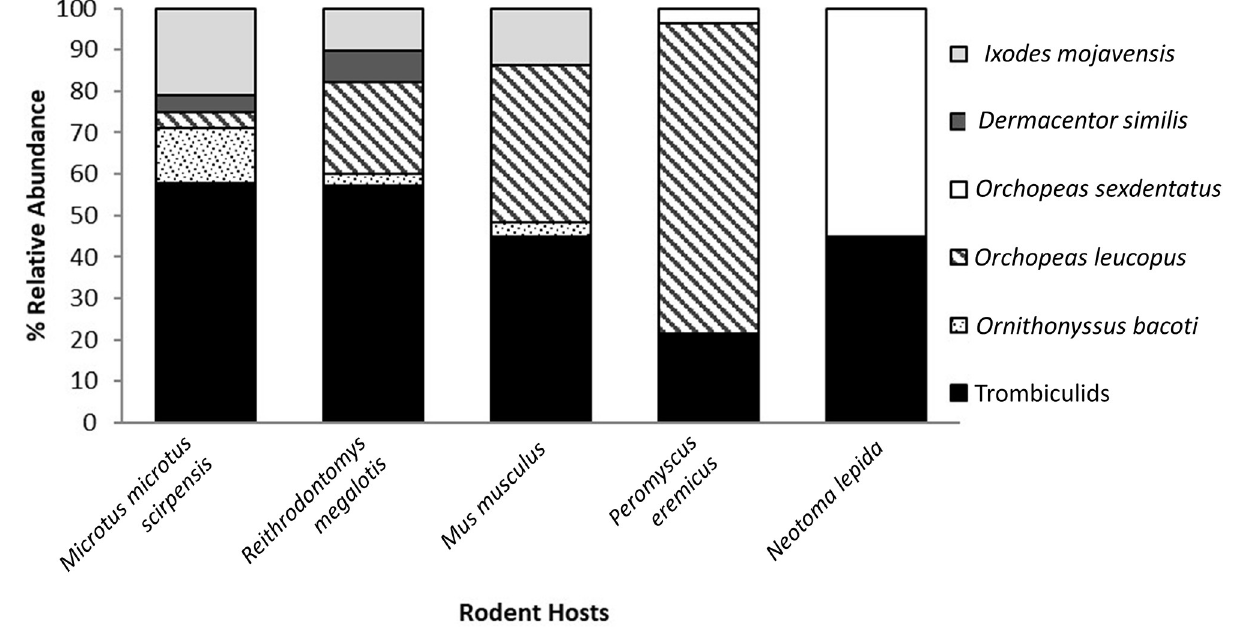
Fig 2. Distribution of rodent ectoparasite taxa among marshes near Tecopa, California, US.